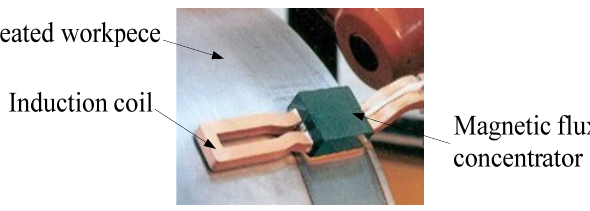
Figure 1. Application of the planar induction heating.